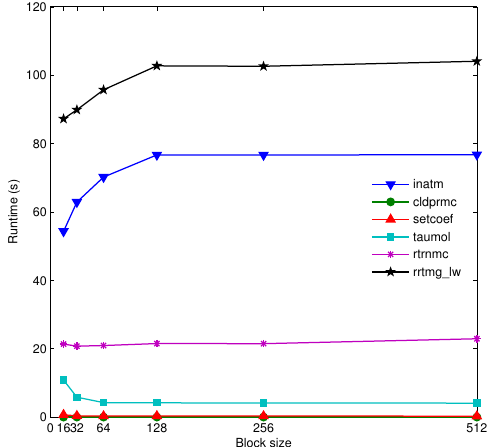
Figure 7. Run-time of the 2-D G-RRTMG_LW on one K20 GPU.